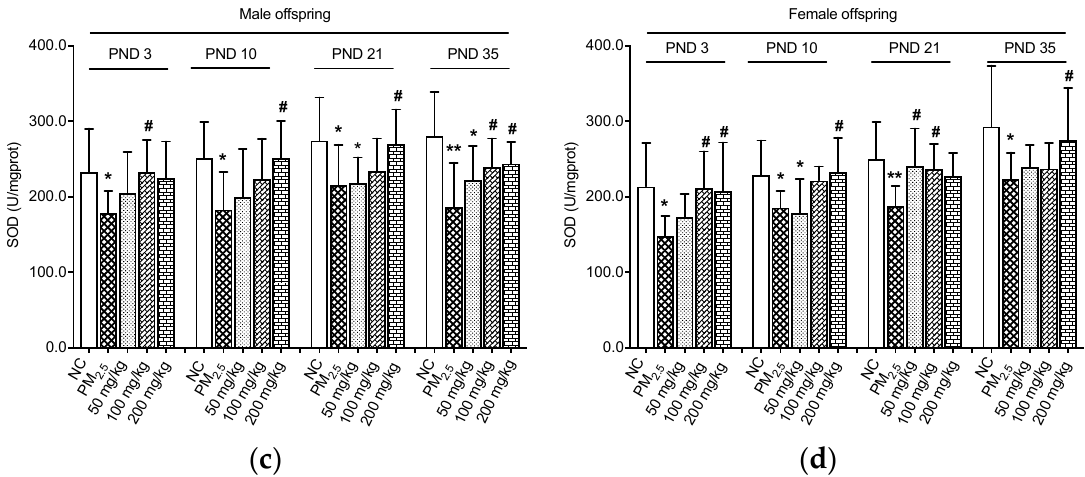
Figure 2. Effects on antioxidant enzymes of colon. ( a ) CAT levels of male offspring; ( b ) CAT levels of female offspring; ( c ) SOD levels of male offspring; ( d ) SOD levels of female offspring. Compared with the NC group, * indicates p < 0.05, ** indicates p < 0.01. Compared with the PM 2.5 group, # indicates p < 0.05, ## indicates p < 0.01. NC: normal control; PM 2.5 : fine particulate